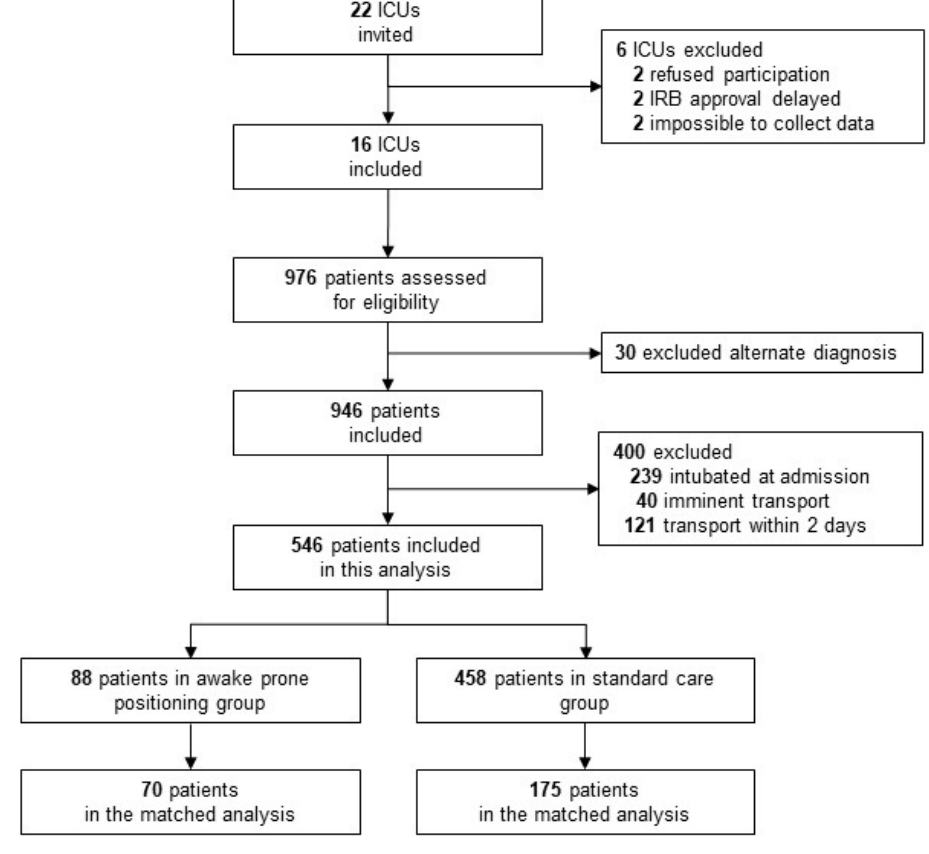
Figure 1. Flow chart of patient inclusion. Most patients were male, and were overweight or obese. Patients were severely ill, as reflected by high disease severity scores, and had severe hypoxemia despite high levels of FiO 2 that was often supplied by means of HFNO. After hospital admission, patients were admitted to the ICU within one or two days (Table